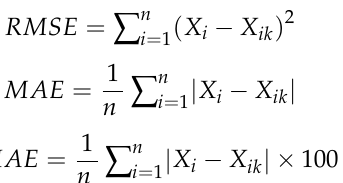
dataset, Table S3. Actual and predicted Andrographolide content of validation dataset, Table S4. Geographic locations and habitats characteristics of Andrographis paniculata populations, Table S5. Table S6. Climatic data for Andrographis paniculata accessions from different geographical regions of Eastern